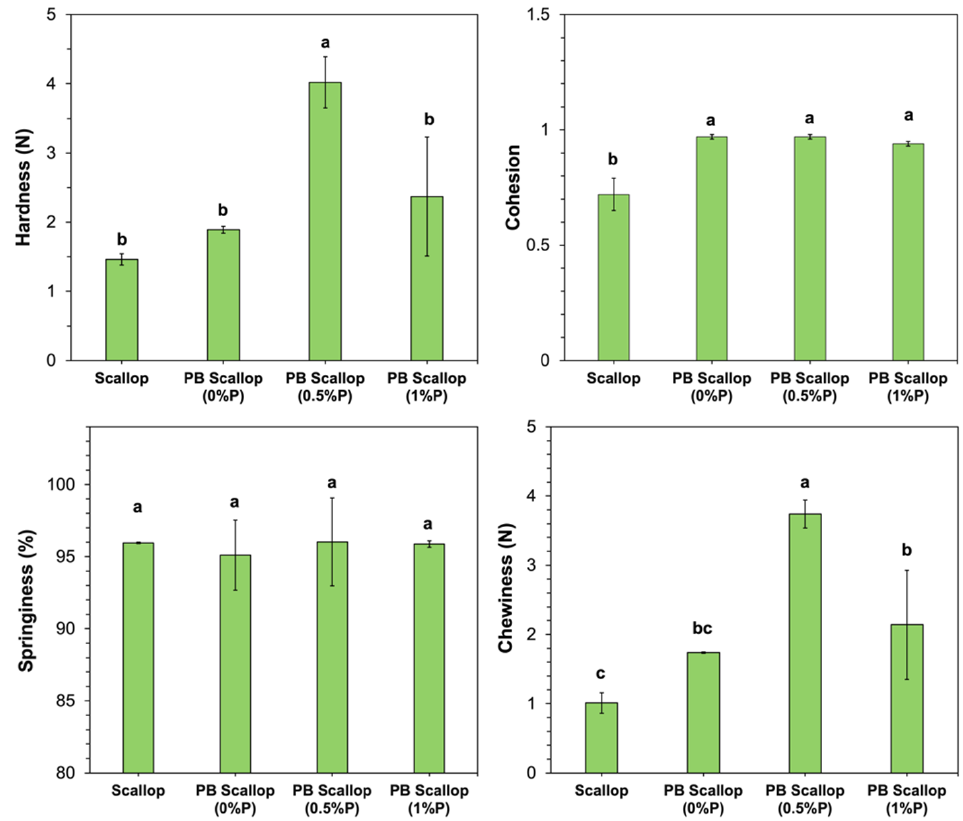
Figure 4. Textual profile analysis of raw scallop and uncooked scallop analogs containing different pectin concentrations. All scallop analogs contained 10% pea protein and 2% transglutaminase. Error bars represent the standard errors ( n = 3), and similar letters mean no statistical difference between treatments ( p ≤